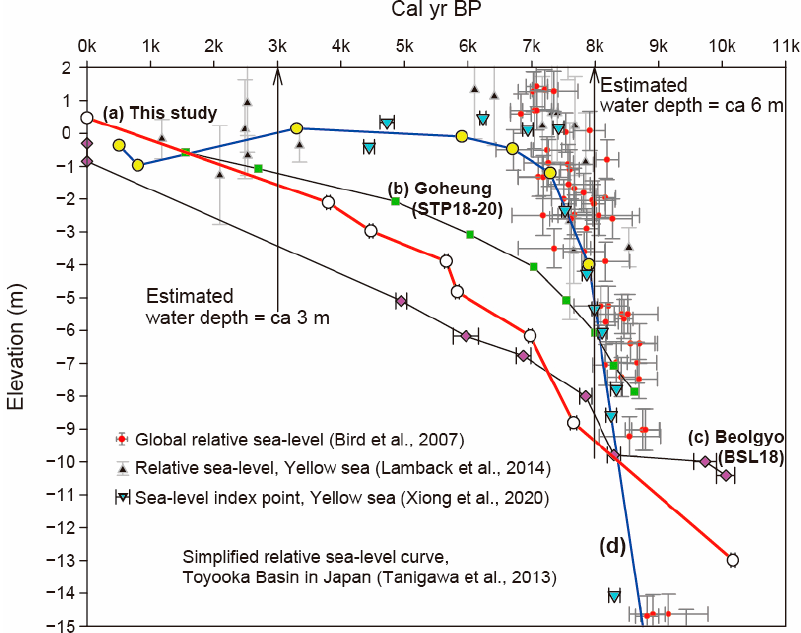
Figure 4. Comparison of estimated sea level curves from ( a ) the Deukryang area (core BSL11, this study; white circles on red line), ( b ) the Goheung area (core STP18-20 [11]; green squares on black- line), ( c ) the Beolgyo area (core BSL18 [4] purple diamonds on black line), and ( d ) simplified relative sea level curve of the Toyooka basin [6] turquoise inverted triangles on blue line). Other points refer to sea level fluctuations in the Yellow sea between China and around the coastal area of Korea [3,7] and global relative sea level [1].